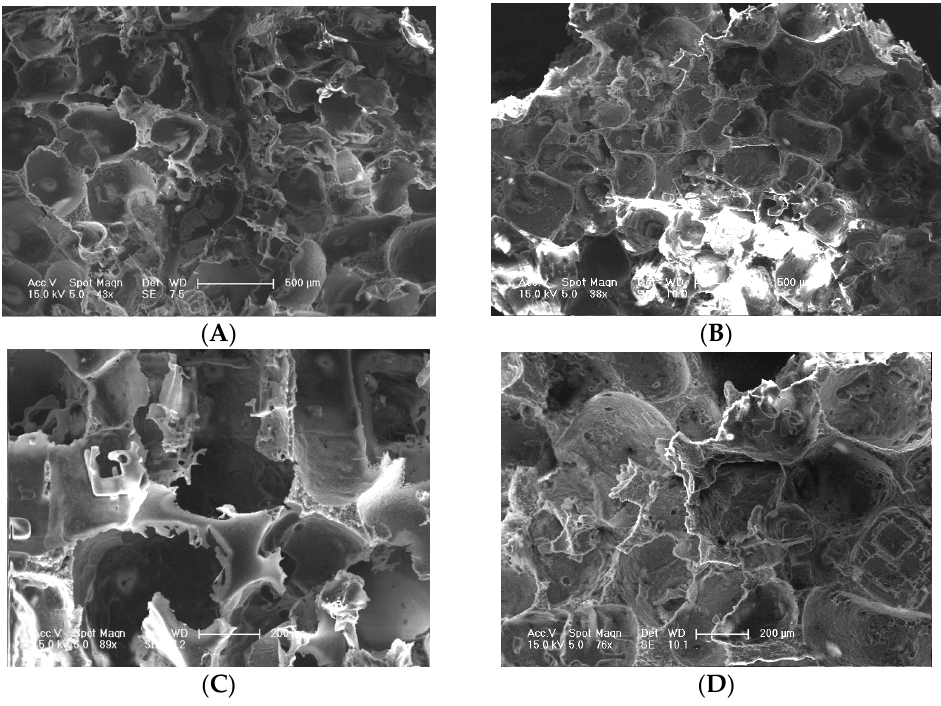
Figure 1. SEM images of S PI ( A , C ) and S MM microstructures ( B , D ). The bar lengths are 500 μ m ( A , B ) and 200 μ m ( C , D ), respectively.